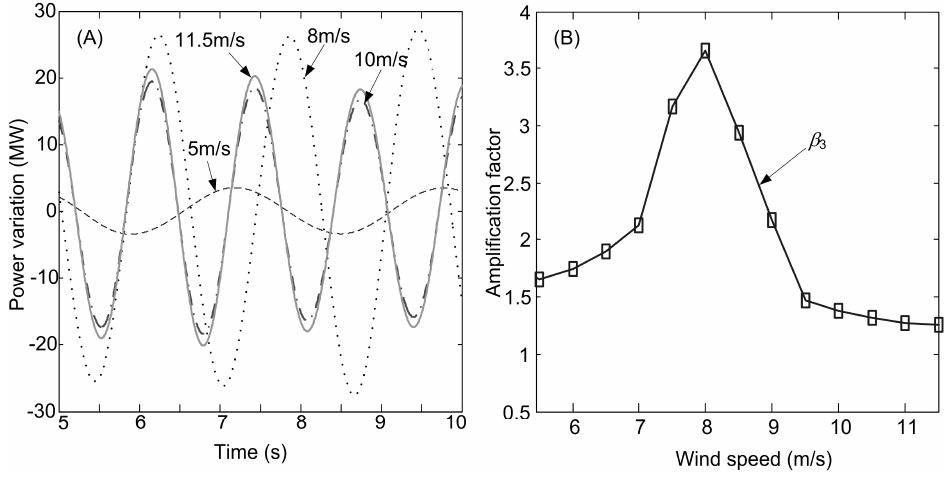
Figure 11. Response of tie-line power and amplification with different wind